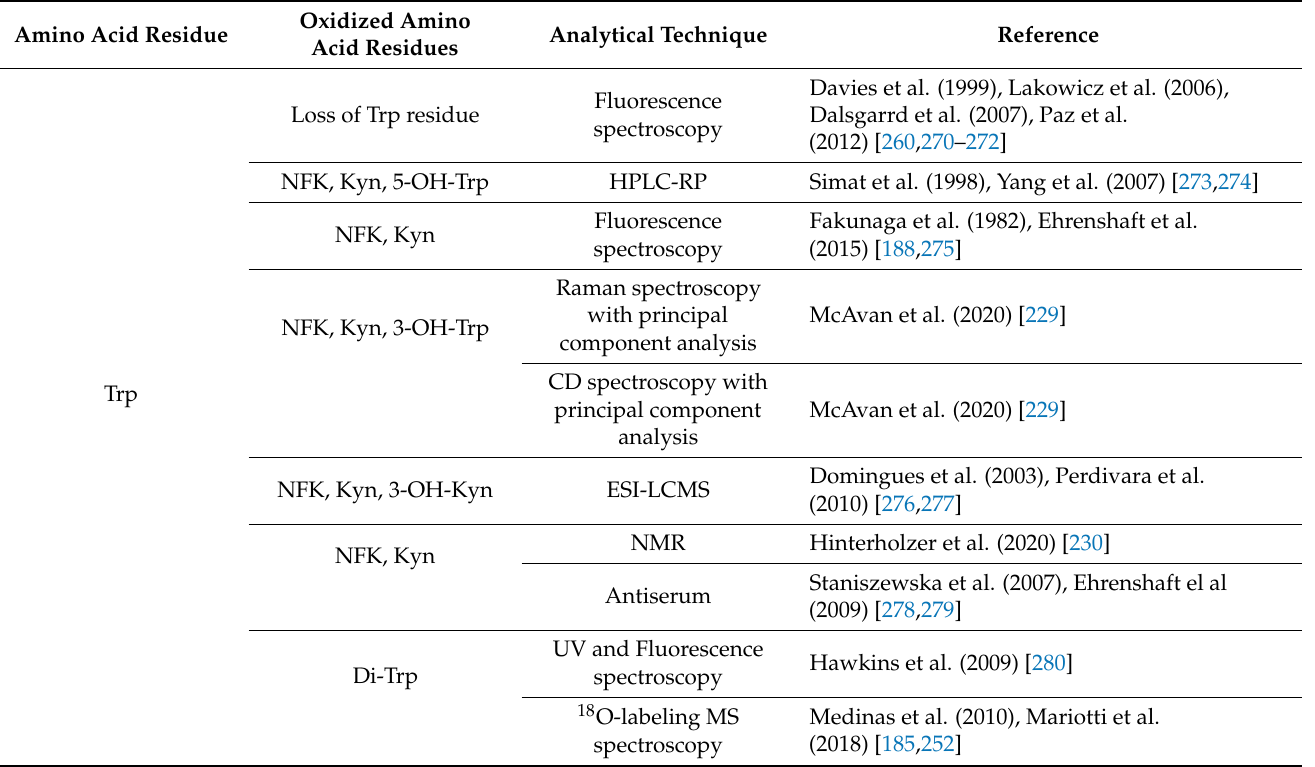
Figure 1. Chemical structures of Tryptophan and common Tryptophan photo-oxidation products such as Kyn, NFK, or 3-OH-Kyn. Table 5. Analytical techniques/assays to detect Trp oxidation products with the corresponding analytical techniques and relevant references.